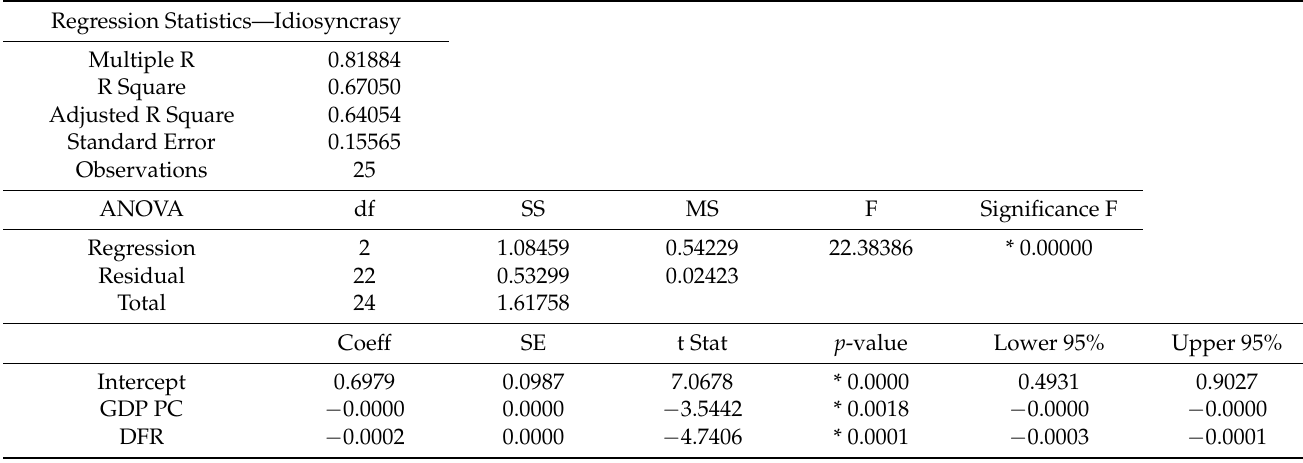
Table 6. Multiple linear regression model analysis in respect of DRs